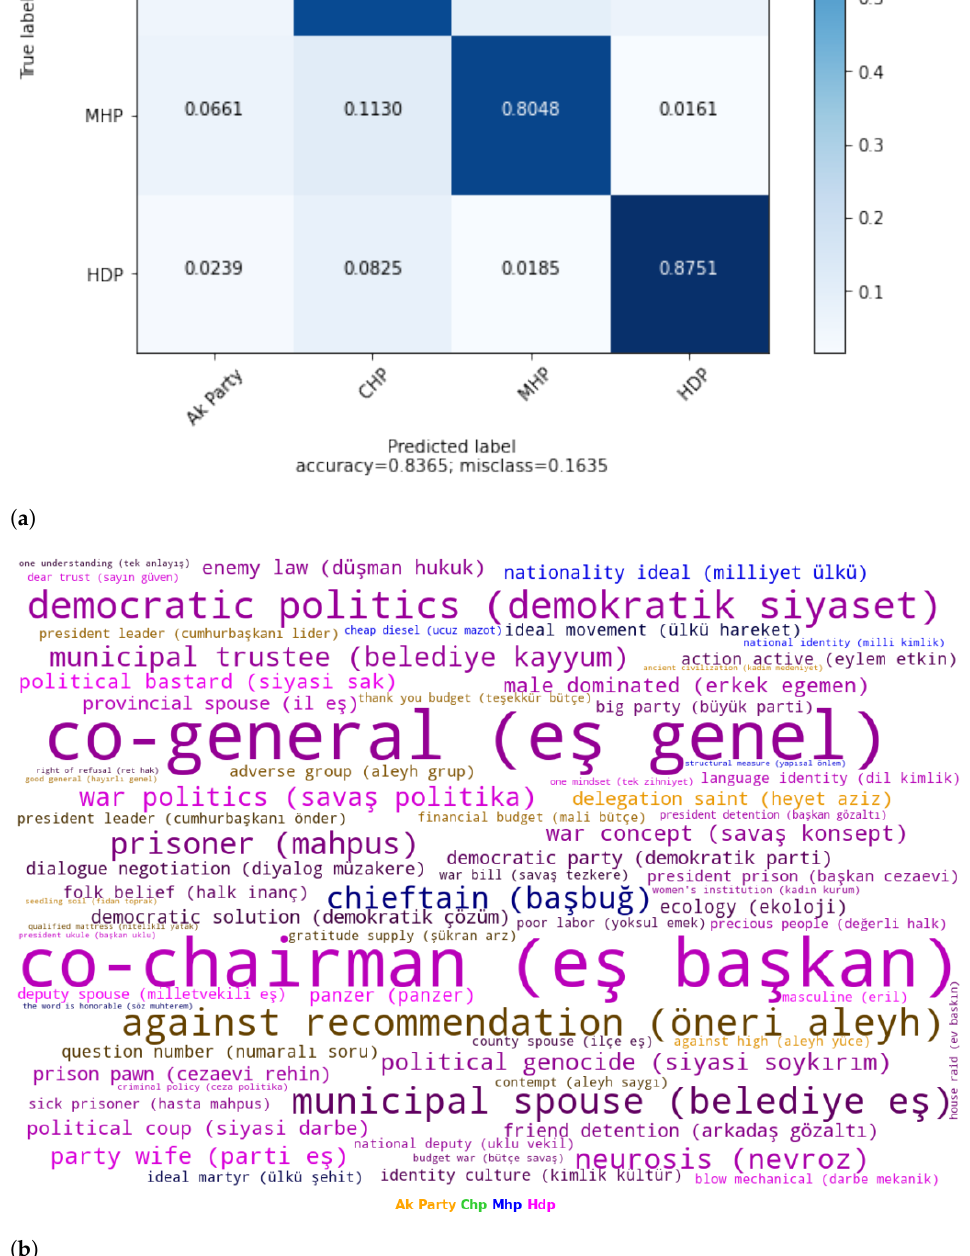
Figure 6. ( a ) Confusion matrix for party classification with TF-IDF (word) _SVM. ( b ) Best terms of political party affiliation of